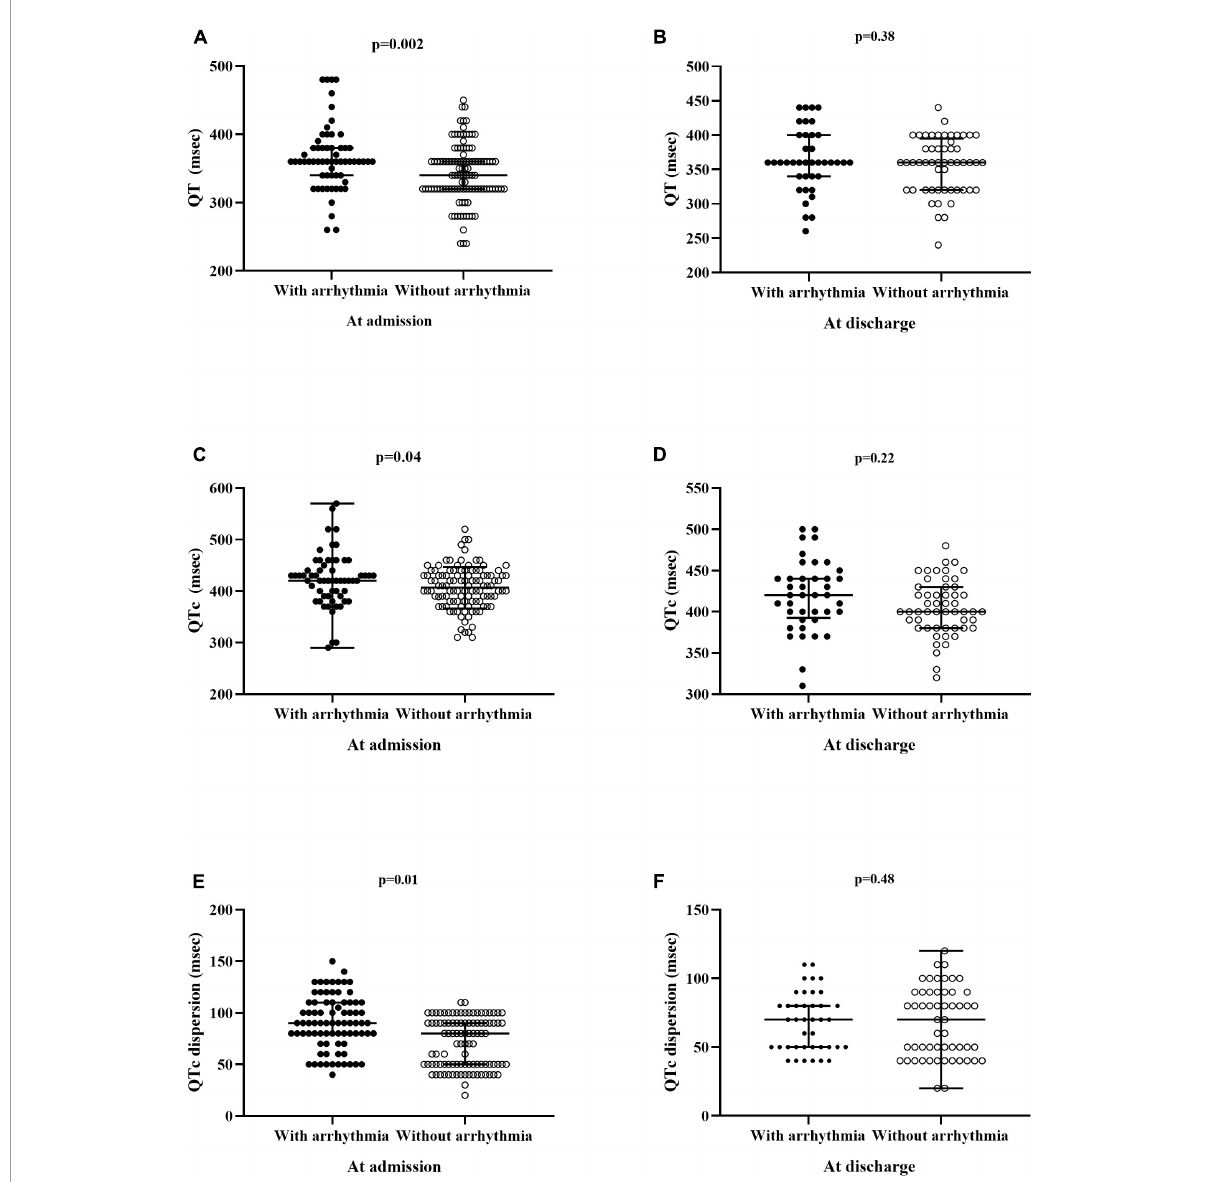
FIGURE1 ECG parameters in patients with and without arrhythmia monitored on cardiac telemetry. (A,C,E) Data of patients ( n = 200) at admission. (B,D,F) Data of patients ( n = 179) at discharge. QTc, heart rate-corrected QT